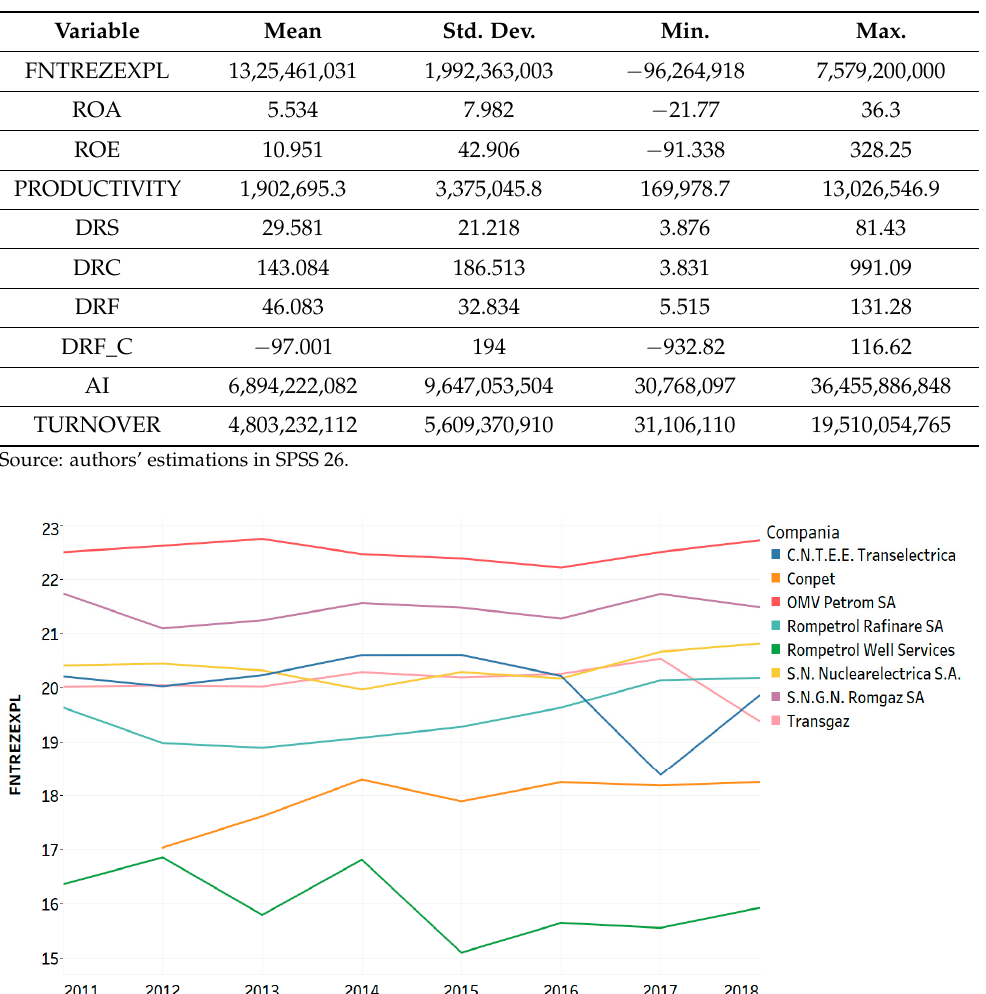
Table 2. Descriptive statistics of the non-transformed variables.